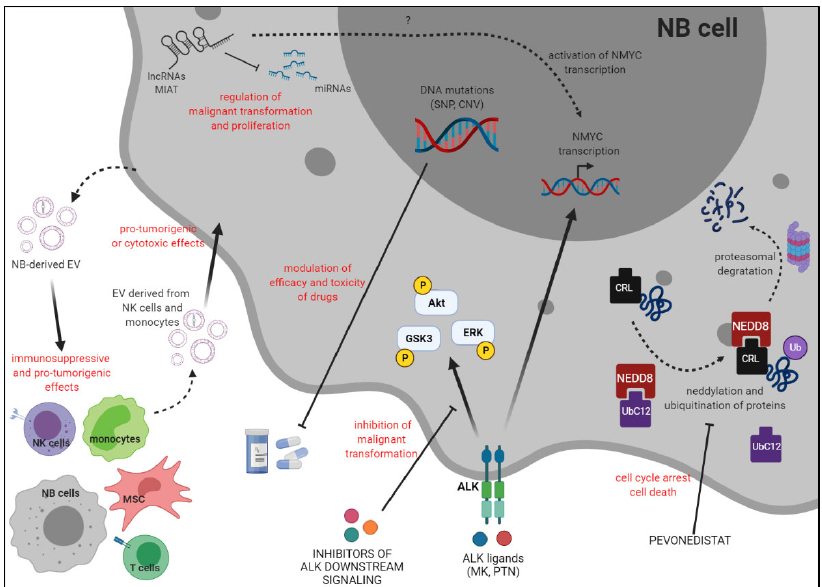
Figure 1. Summary of the main topics addressed in this Special Issue.